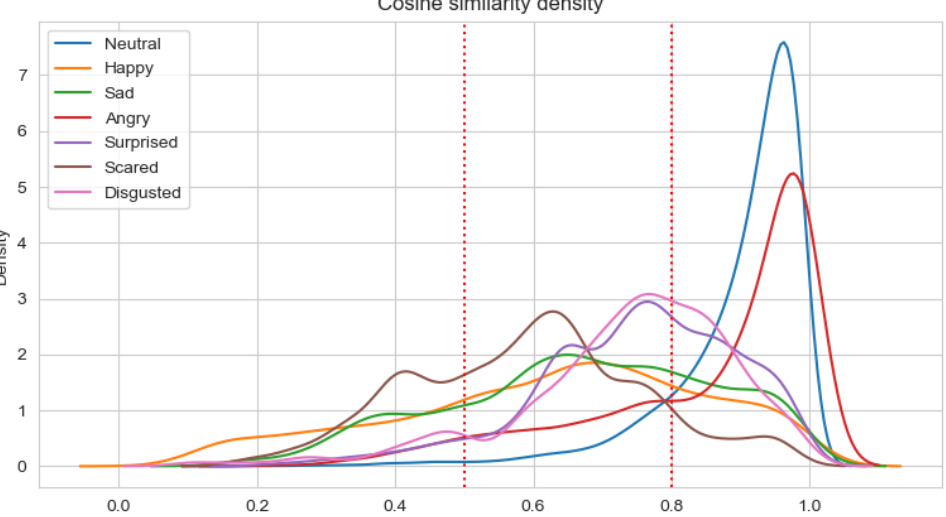
Figure 10. Density plot for Ekman’s emotions with neutral state in Experiment